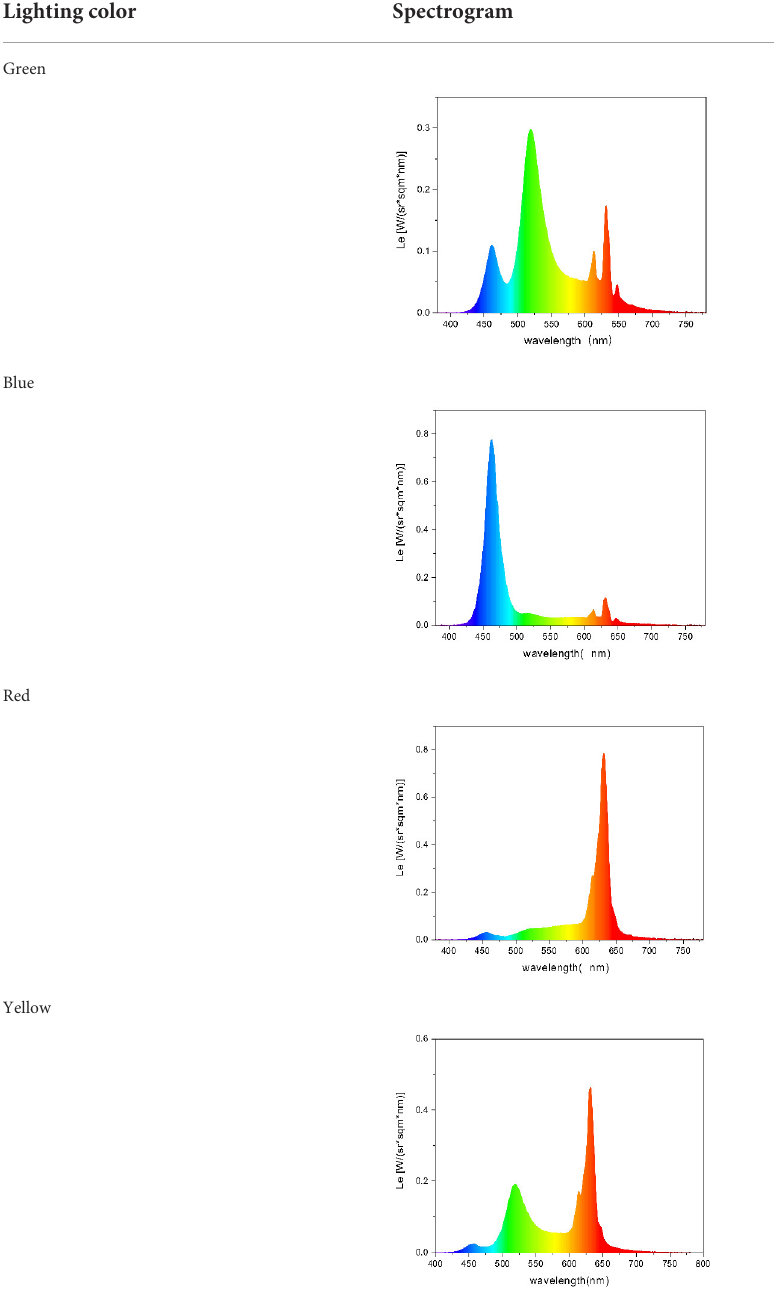
TABLE 1 Light color